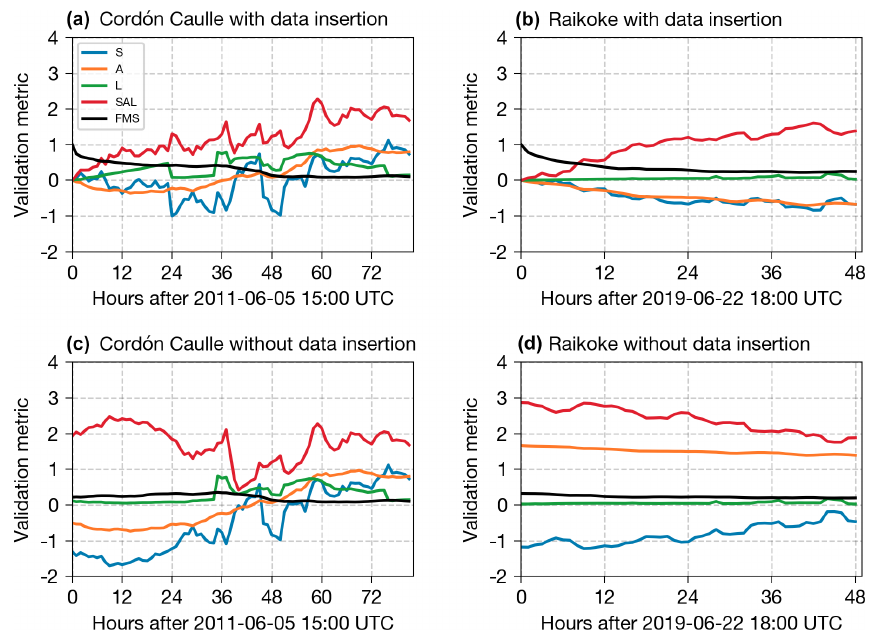
Figure 3. Time series of validation metrics for (a) Puyehue-2011 test case with data insertion, (b) Raikoke-2019 test case with data insertion, (c) Puyehue-2011 without data insertion, and (d) Raikoke-2019 without data insertion.